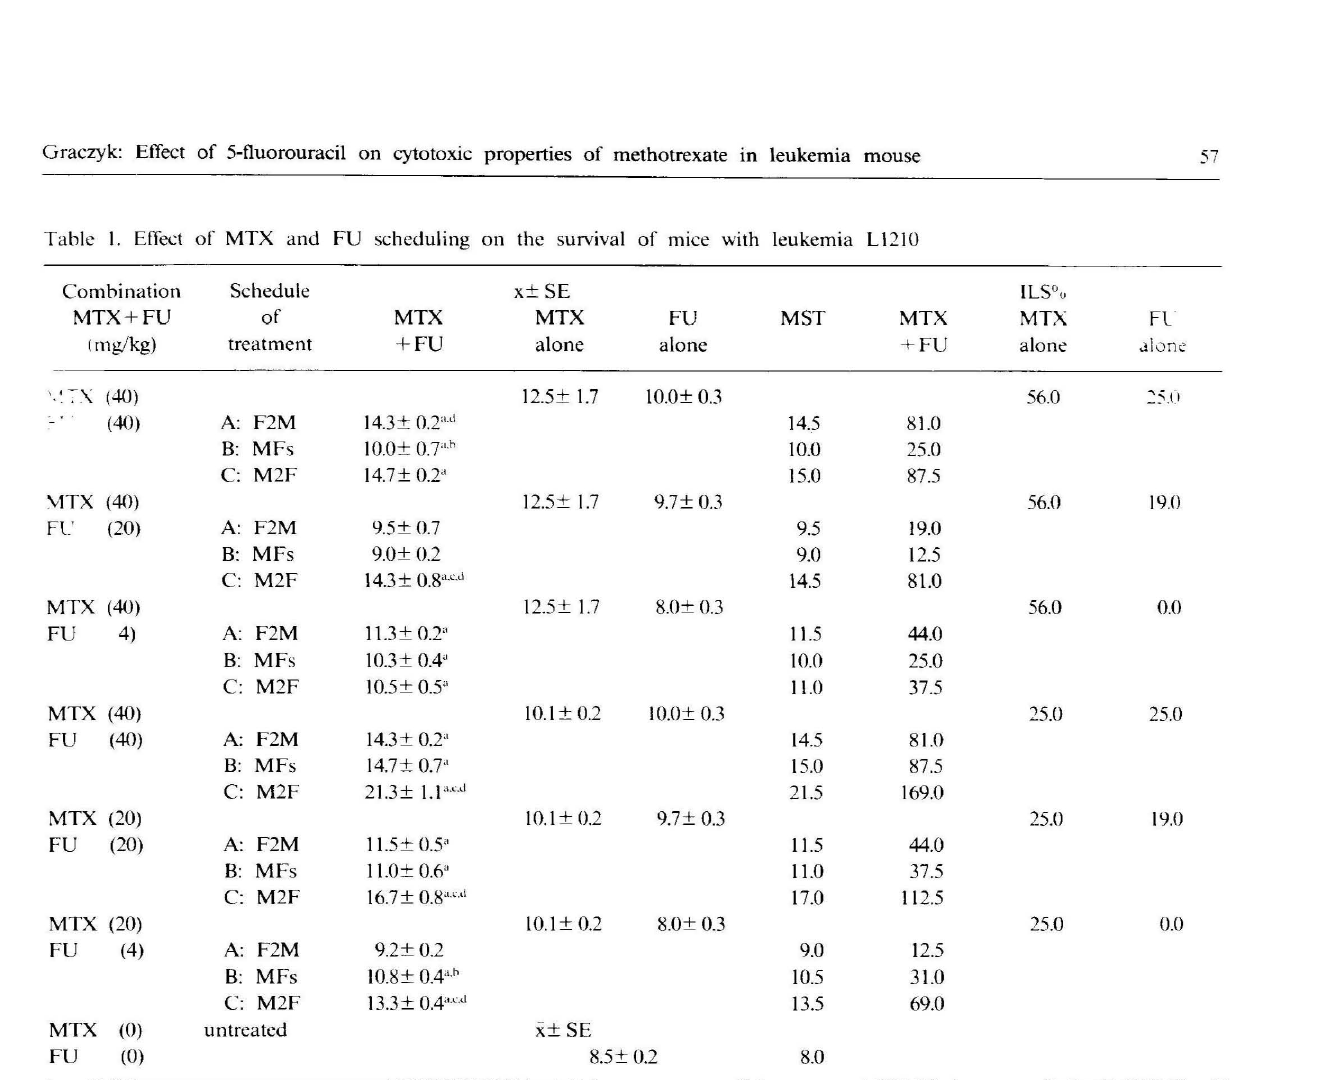
Table I. Effect of MTX and FU scheduling on the survival of mice with leukemia Ll210